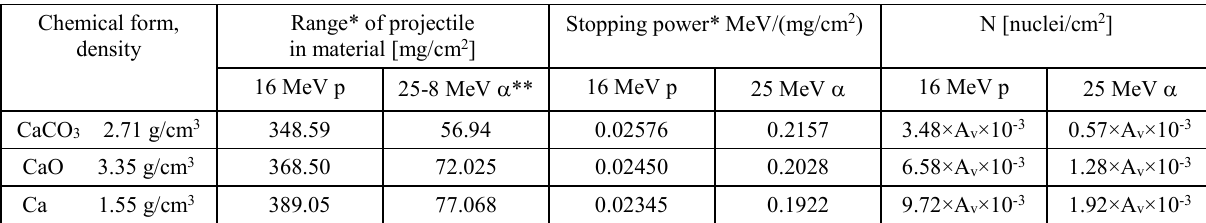
Fig. 1. CaCO 3 target after 2 h irradiation with 15 µA proton beam of 16 MeV . Table 3. 16 MeV proton and 25 MeV alpha ranges and stopping powers in calcium